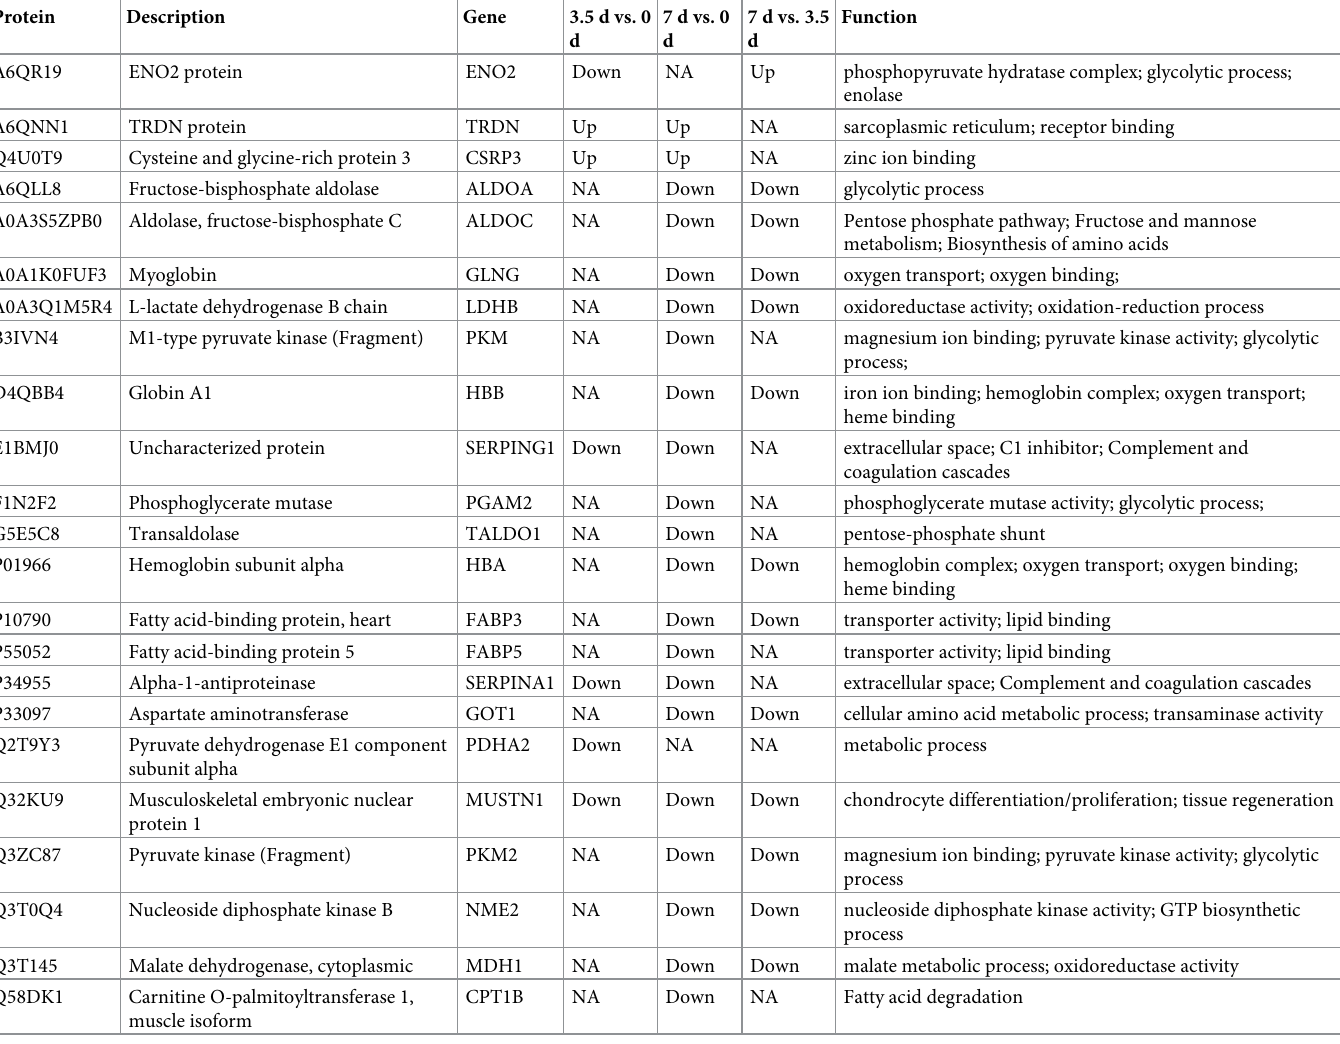
Table 1. Description of several key differentially expressed